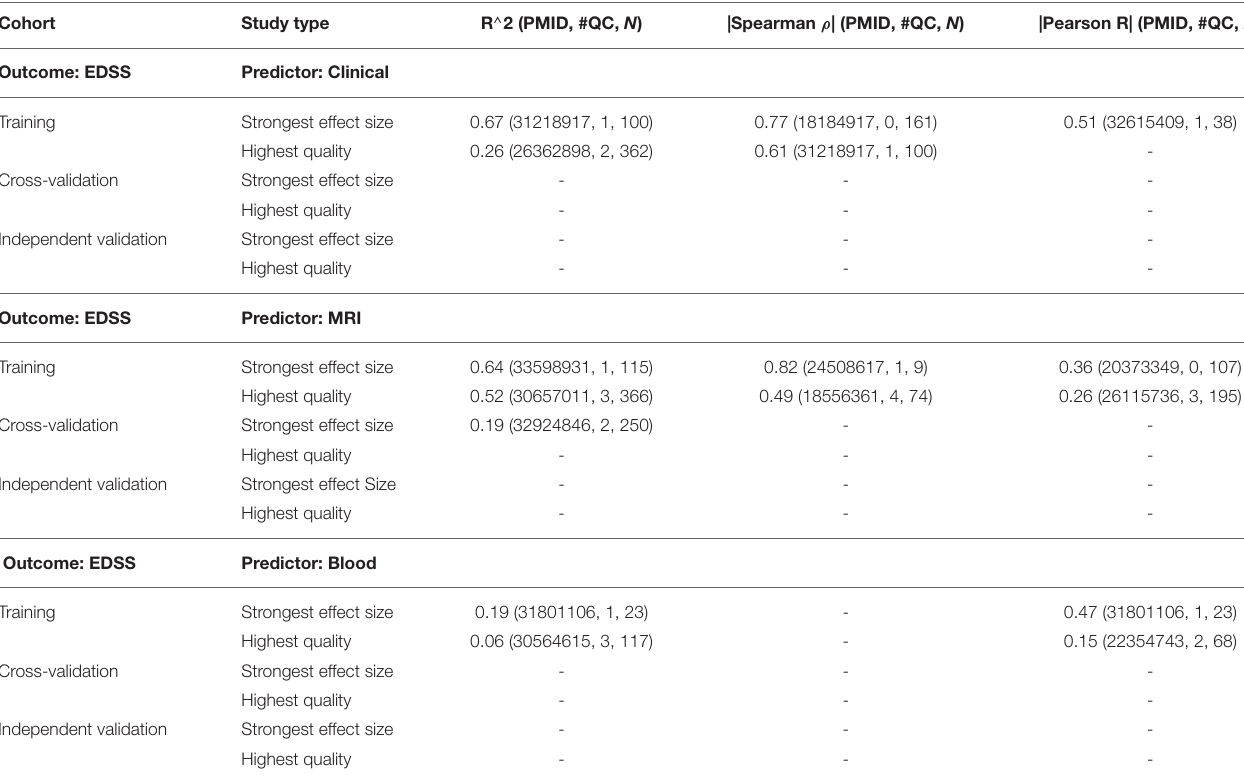
TABLE 1 | This set of tables shows the models of expanded disability status scale (EDSS; modeled as ordinal scale) using the following predictor types: clinical, magnetic resonance imaging (MRI), and blood, respectively. Cohort Study type R ∧ 2 (PMID, #QC, N ) |Spearman ρ | (PMID, #QC, N ) |Pearson R| (PMID, #QC, N